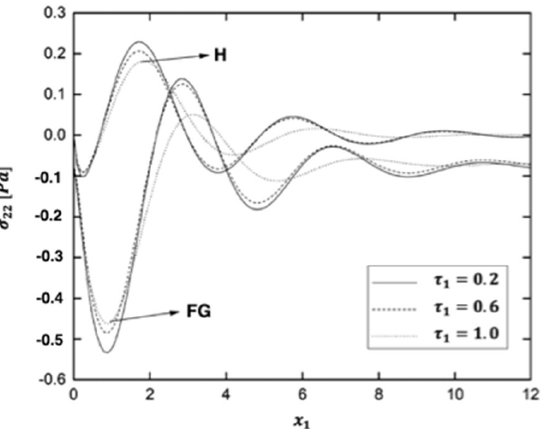
Figure 16. Variation of the thermal stress wave σ 22 along x 1 − axis in the functionally graded (FG) and homogeneous (H) anisotropic fiber-reinforced plates under different values of time characteristic of the laser pulse.